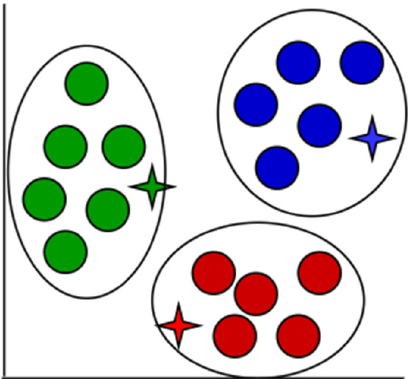
Figure 9. Step 6— K -means: K = 3 Step 6: Repeat previous steps until it has reached the point where the data points do not switch to another cluster. Here, it can be seen that there are three distinct clusters. While the figure shown has taken form in a short period of time, this approach normally requires several trials.